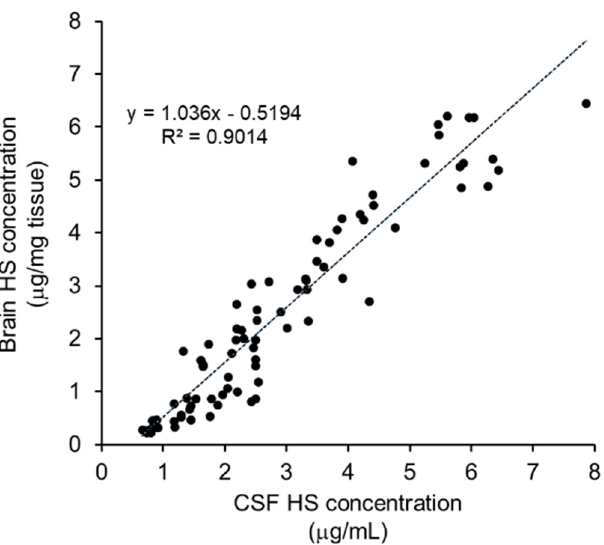
Figure 5. Correlation between concentrations of HS in the brains and the CSF of MPS II mice treated with pabinafusp alfa. Results from studies of single-dose, 4-week, 8-week, 12-week, and 36-week treatments are included.